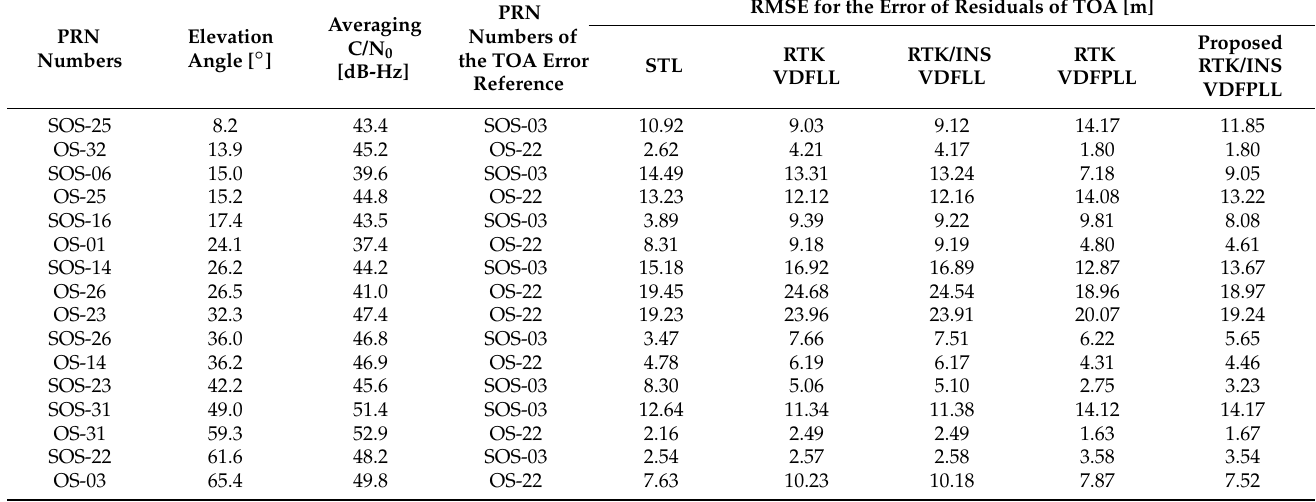
Table 2. RMSEs of the TOA estimates from the active satellites regarding the two stationary experi- ments where the reference curves for the error of residuals of TOA refer to Figure 16 (“OS” and” SOS” correspond to “open-sky” and “semi-open-sky” testing situations, respectively; “Averaging C/N 0 ” is estimated from the “Ground-truth-based VDFPLL” SDR).